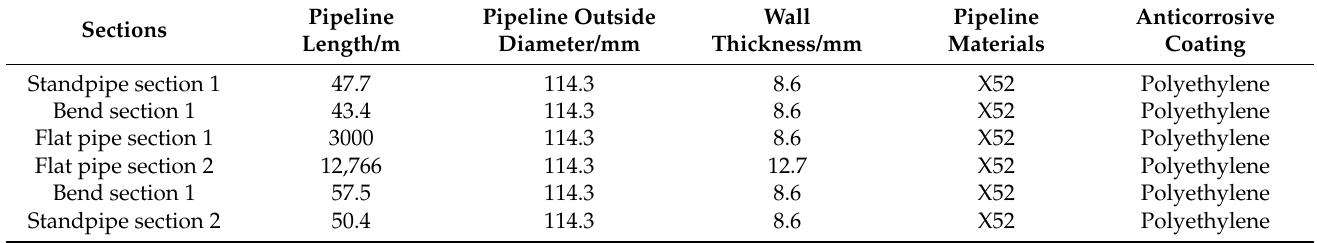
Table 2. Pipe size and material parameters.